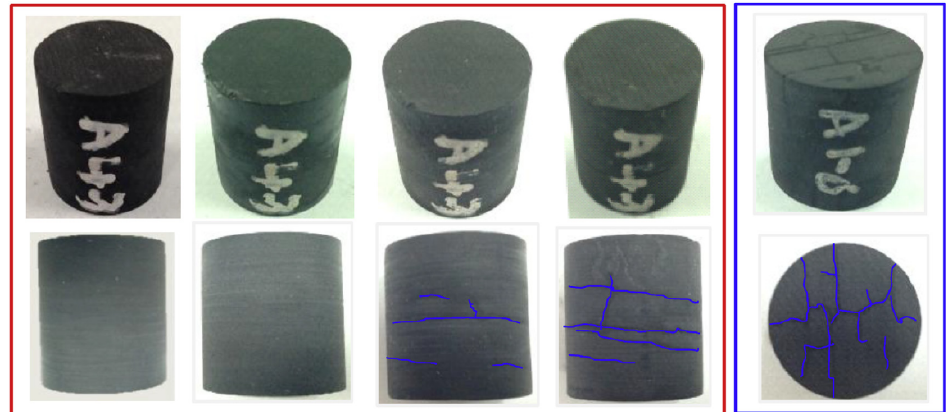
Figure 20. Failure patterns of shale under the condition of thermal shock by soaking the specimen in liquid nitrogen. ( a ) Test results of Cha [17]; ( b ) test results of Han [32].